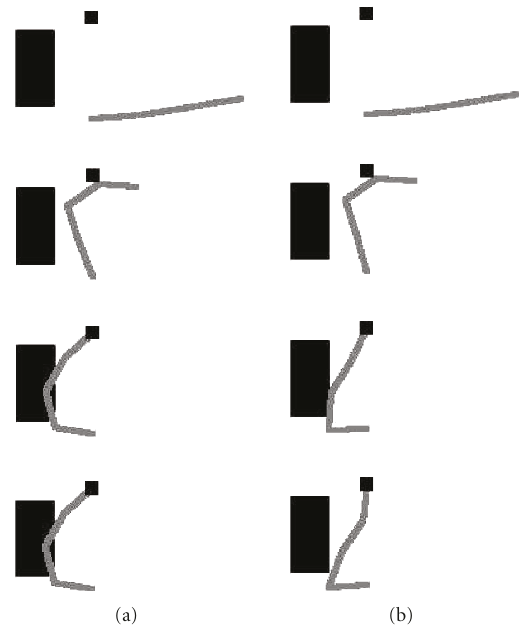
Figure 8: Experiment 3. From initial configuration of the chain (gray) the experiment try to avoid an object (black). Left column, sequence applying inverse kinematics without image constraint. Right column, sequence applying inverse kinematics with image